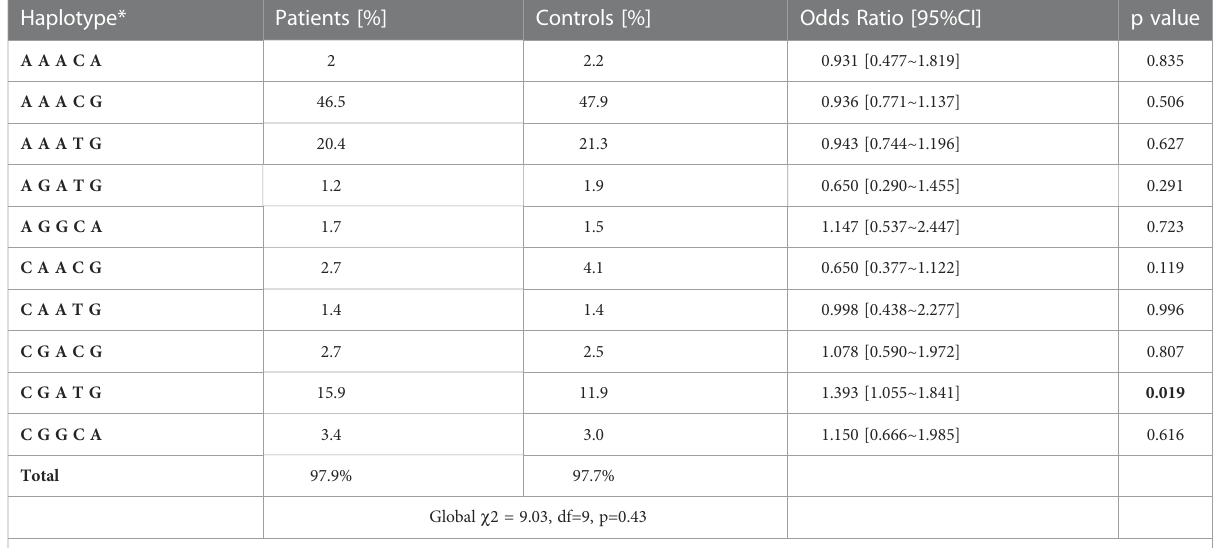
TABLE 4 BTLA haplotypes frequency in NSCLC patients and controls.